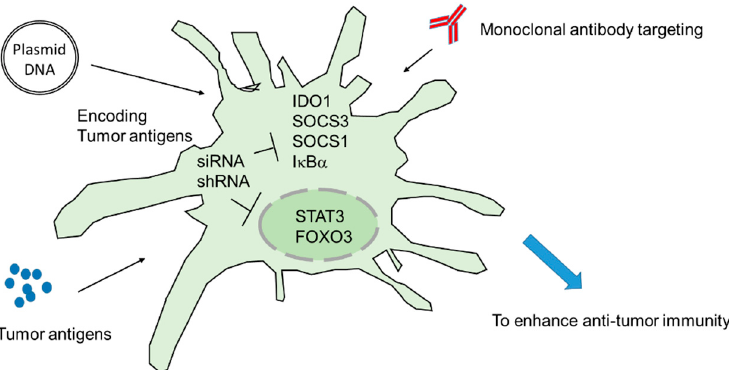
Figure 2. Combination of siRNA/shRNA and other cancer immunotherapies. The inhibition of the negative immune regulator in DCs results in strong immune activation. When DCs are delivered with plasmid DNA (DNA vaccine)-encoding specific tumor antigens or DCs pulsed with specific antigens, DCs-mediated anti-tumor immunity is significantly enhanced. Moreover, the monoclonal antibodies targeting CTLA-4 and PD-1 might further enhance tumor-specific immune activation.